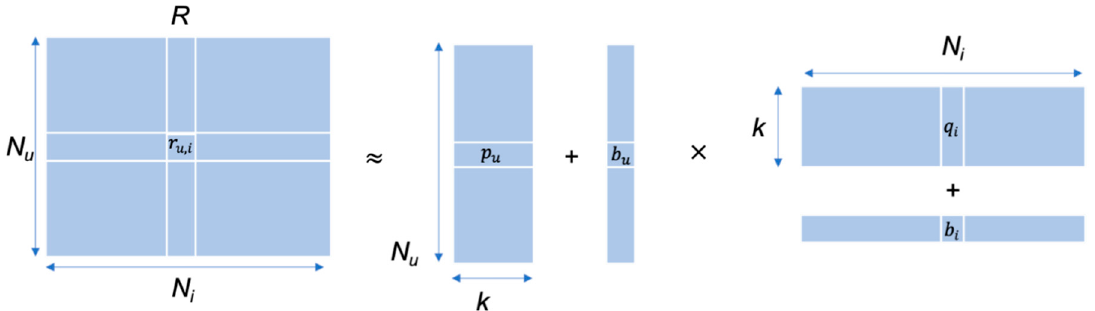
Figure 1. Rating matrix approximation with latent features.